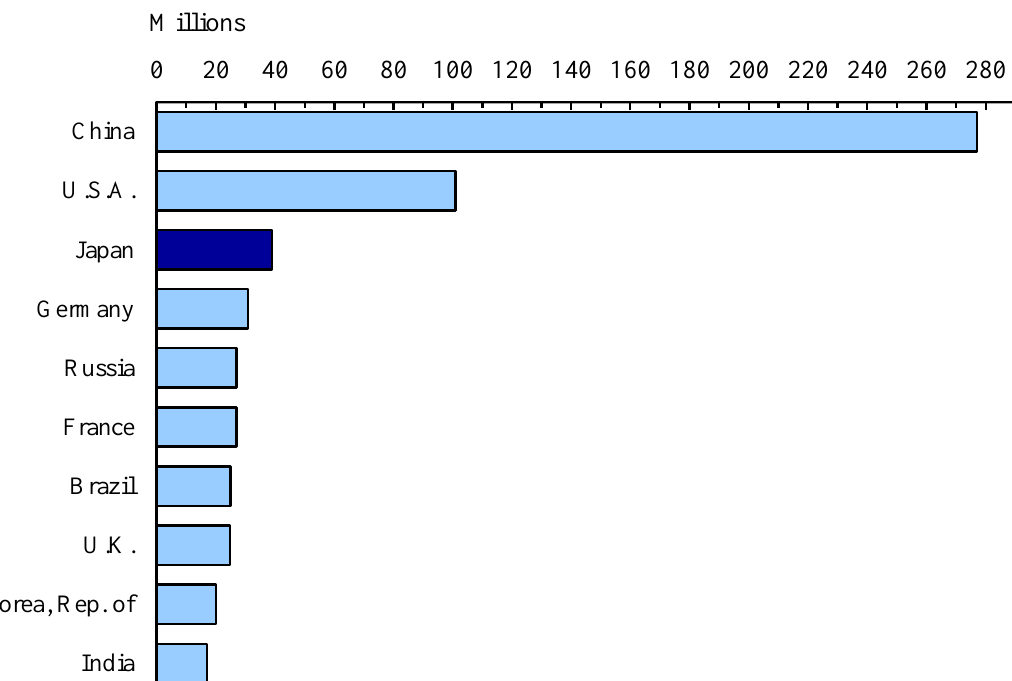
International Comparison of Fixed Broadband Subscribers (2015)